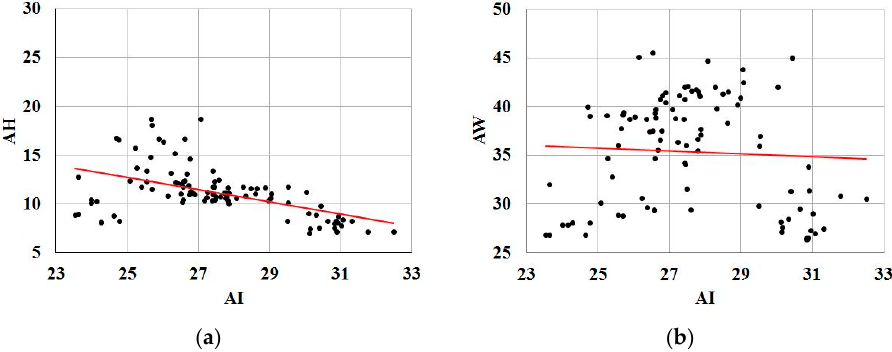
Figure 12. Linear regression analysis for 99 datasets: ( a ) scatter plot showing regression between AI and AH (correlation coefficient r = − 0.51, p < 0.0001), and ( b ) scatter plot showing regression between AI and AW (correlation coefficient r = − 0.06, p =